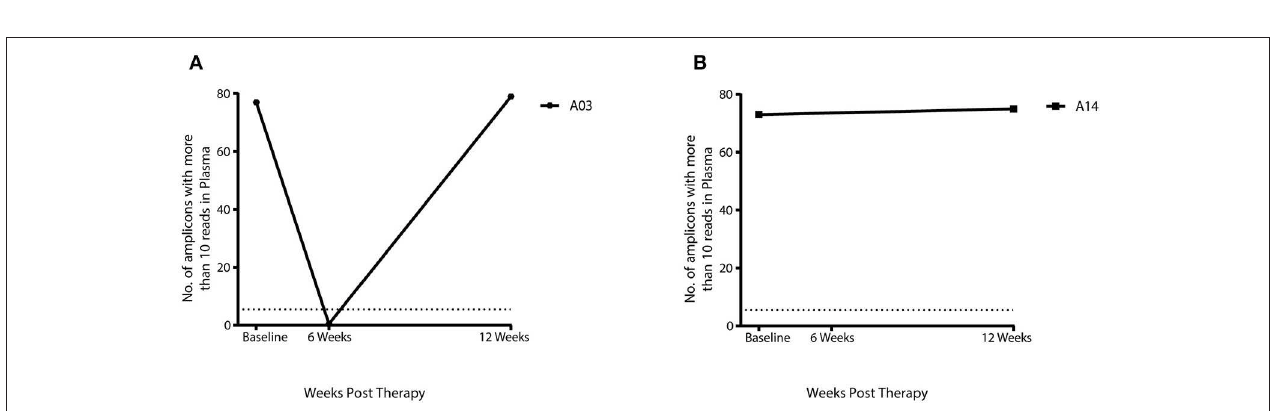
FIGURE 2 | cHPV DNA levels in 2 patients with either a partial response or relapse using panHPV-detect. (A) In patient A03 cHPV-DNA was below threshold levels at 6 weeks, cHPV-DNA levels then increased above threshold at 12 weeks with residual disease on DRE/MRI (B) Above threshold levels of cHPV-DNA in patient A14 with complete response on DRE/MRI, distal relapse was detected at 9 months post-CRT The dashed line on the Y-axis denotes the panHPV-detect threshold at 5.5 amplicons with more than 10